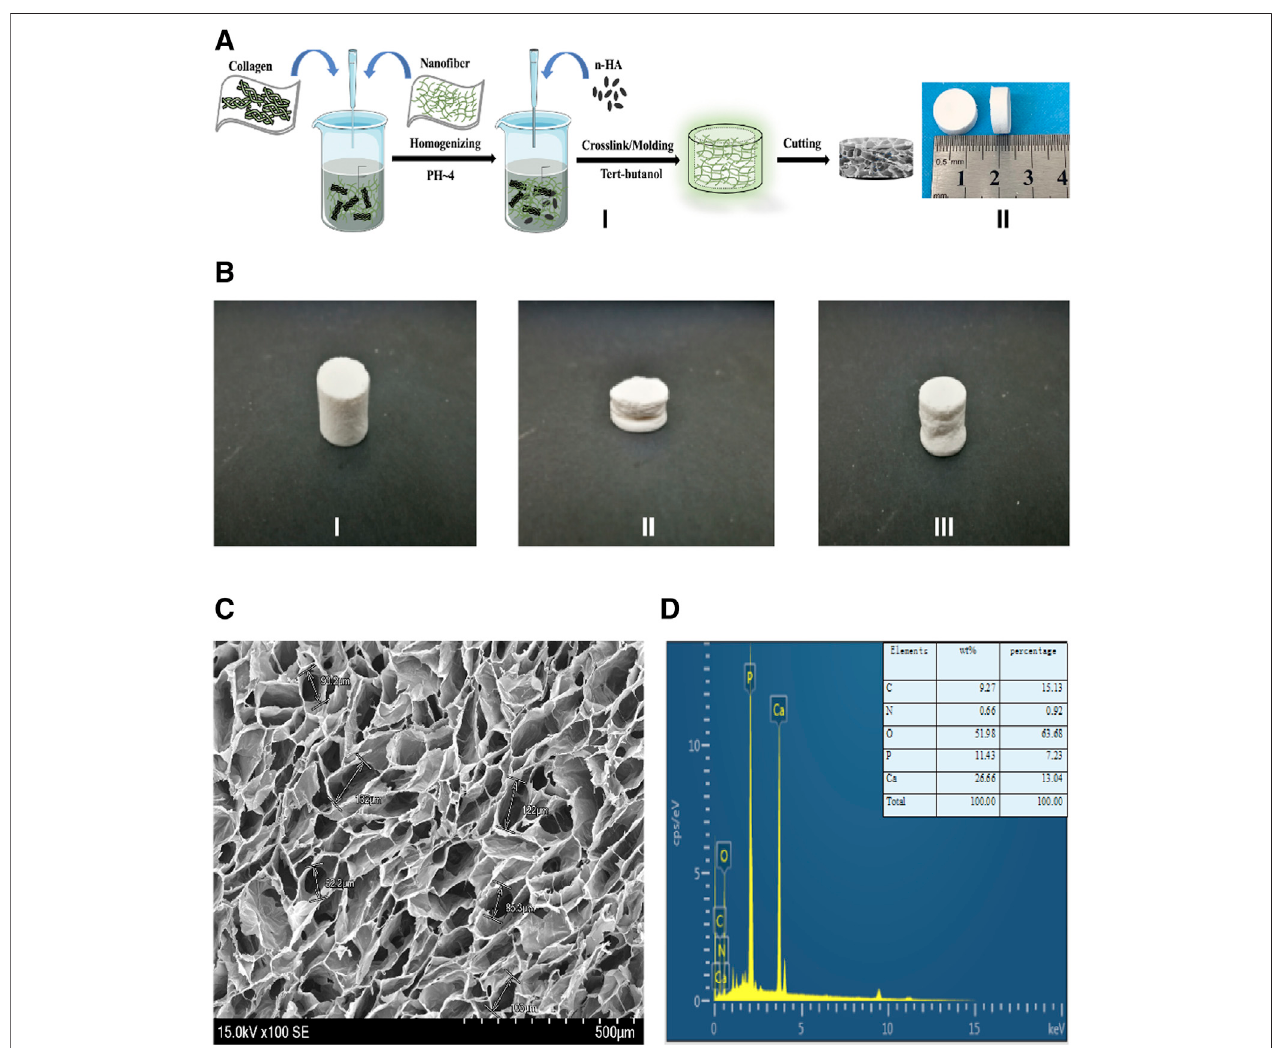
FIGURE1| Thefabrication process, characterizationoftheNCF-Col-NHAaerogel scaffold (A). The fabrication process and appearanceofNCF-Col-NHAaerogel scaffolds. I) show the manufacturing process of aerogel scaffolds: NCF and Col were mixed at a ratio of 2:1, stirred under PH4 conditions, and then added NHA, to get NCF-Col-NHAhydrogel.Afterreplacingthewaterinthehydrogelwithtert-butanol,theNCF-Col-NHAaerogelscaffoldwasobtainedbyfreeze-dryingat-20 ° Cfor48 h.II) is the fi nished product of the aerogel scaffold, which is the white porous scaffold (B). The shape of NCF-Col-NHA aerogel scaffolds could be restored after compression. (C) Morphological observation and elemental analysis of NCF-Col-NHA aerogel scaffolds. Observed under an electron microscope, NCF-Col-NHA aerogelisaporousstructure withlargeandsmallporesconnected (D). Theelementalanalysisofaerogelscaffold, phosphorus(P),calcium (Ca),oxygen(O),and carbon (C) are the main